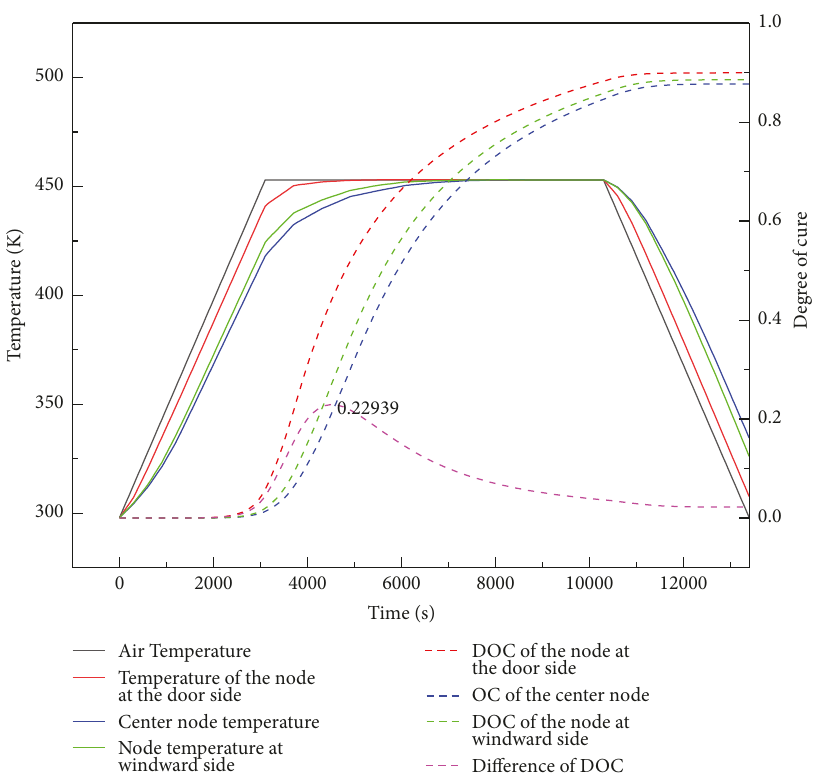
Figure 12: Variations of temperature and curing degree of nodes as the function of time during